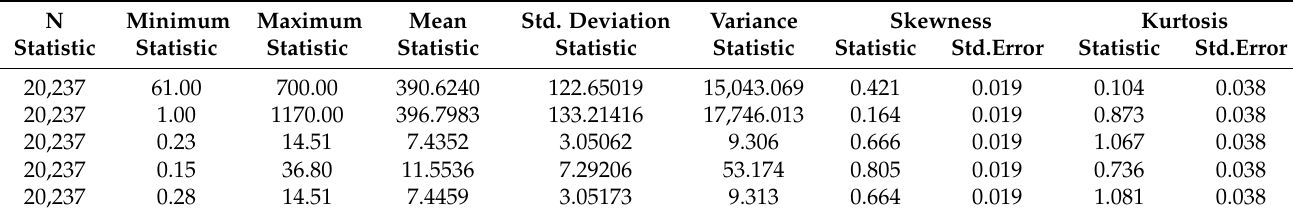
Table 3. Descriptive statistics of data.